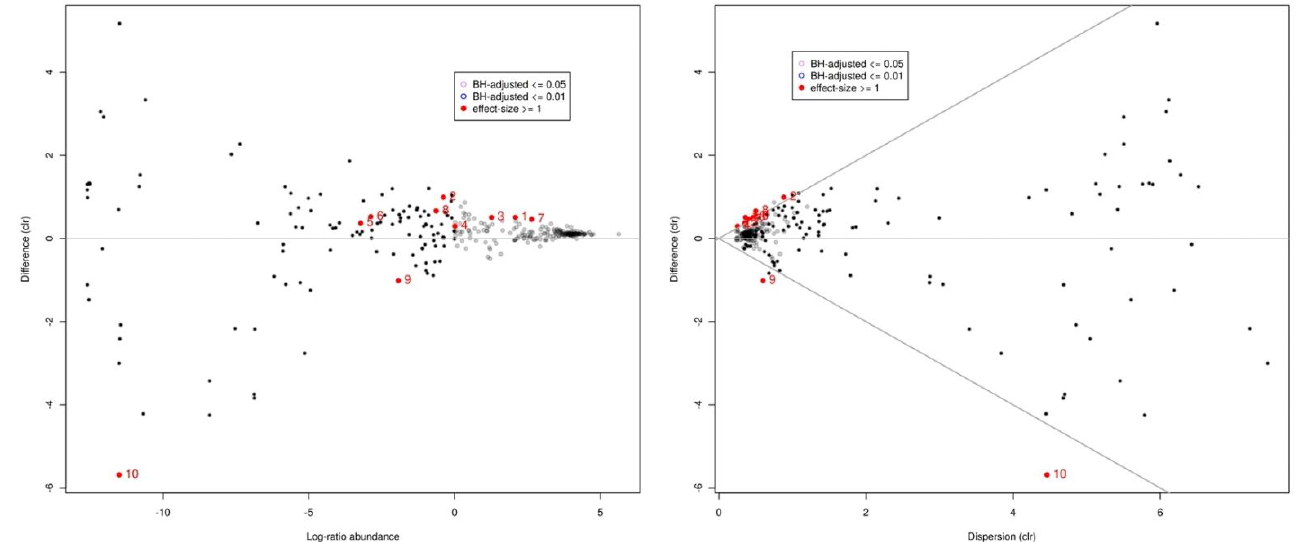
Figure 4. The panel on the left displays the Bland–Altman plot that shows the relationship between Abundance and Difference of the predicted pathways (PWYs) in the presence (lower part) and absence (upper part) of fusariosis. The panel on the right displays the Effect plot that shows the relationship between Difference and Dispersion of the PWYs between Fusarium and not Fusarium groups. In both of the plots, the ‘not significant’ features are shown in grey and black. Features that are statistically significant are in red.